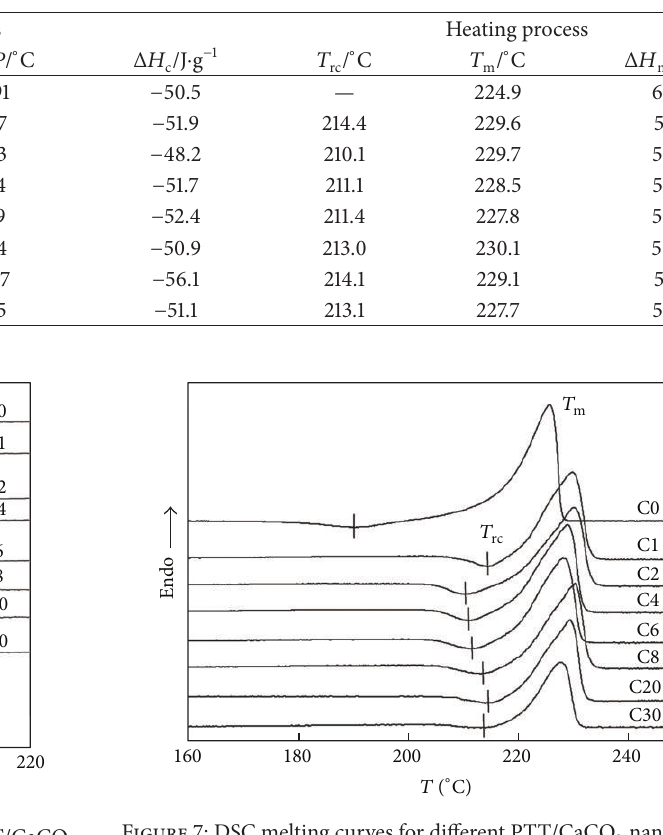
Figure 6: DSC melt-crystallization curves for different PTT/CaCO 3 nanocomposites.